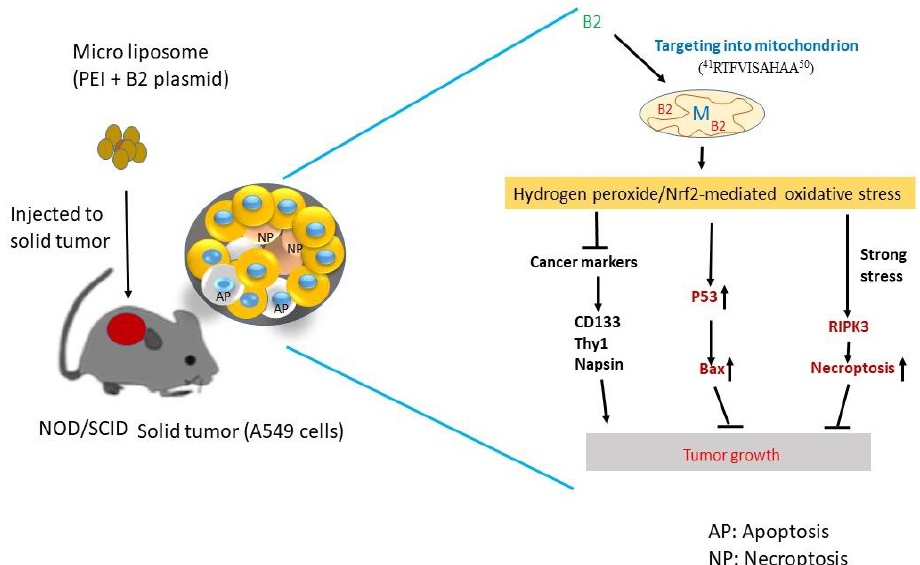
Figure 8. Hypothesized effect of mitochondrion-targeting protein B2 on multiple signaling pathways by ROS-mediated oxidative stress in cancer cells. The expression of the B2 gene in A549 lung tumor cells or in A549 cell-induced solid tumors in NOD/SCID mice induced ROS-mediated stress signals, causing p53/Bax-mediated apoptosis and RIPK3-mediated necroptosis. The B2 protein can transfer into the mitochondria using its novel transferring signal sequence. 41 RTFVISAHAA 50 . It then regulates complex II activity, suppressing ATP production and enhancing ROS generation, thereby repressing cancer cell growth. B2 triggers ROS/Nrf2-mediated stress, further affecting multiple signaling pathways, such as (1) the induction of the p53- and Bax-mediated apoptotic signals and the RIPK3-mediated necroptosis signal, as well as (2) a reduction in the cancer marker expressions of CD133, Thy1, and napsin in mice, which are responsible for cell migration and invasion in lung